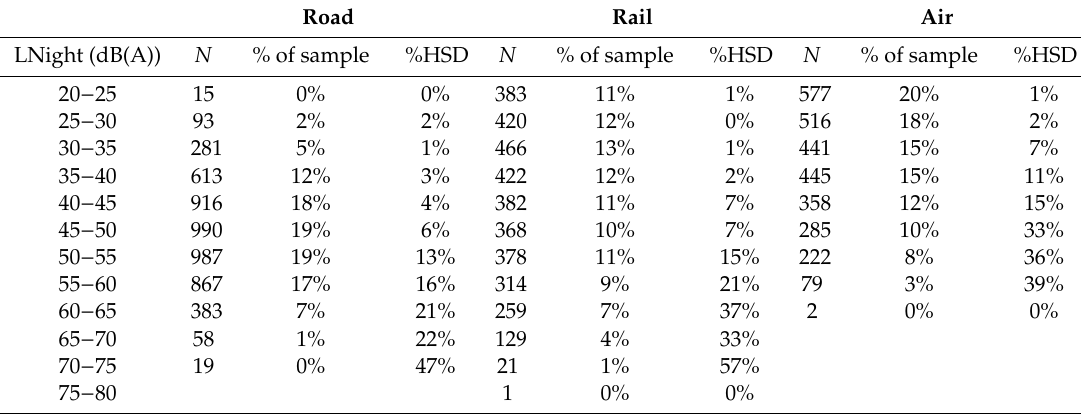
Table 2. Number of cases ( N ) per LNight category, percent of sample in that category, and observed %HSD in each category. LNight refers to the maximum façade point of the dwelling unit.